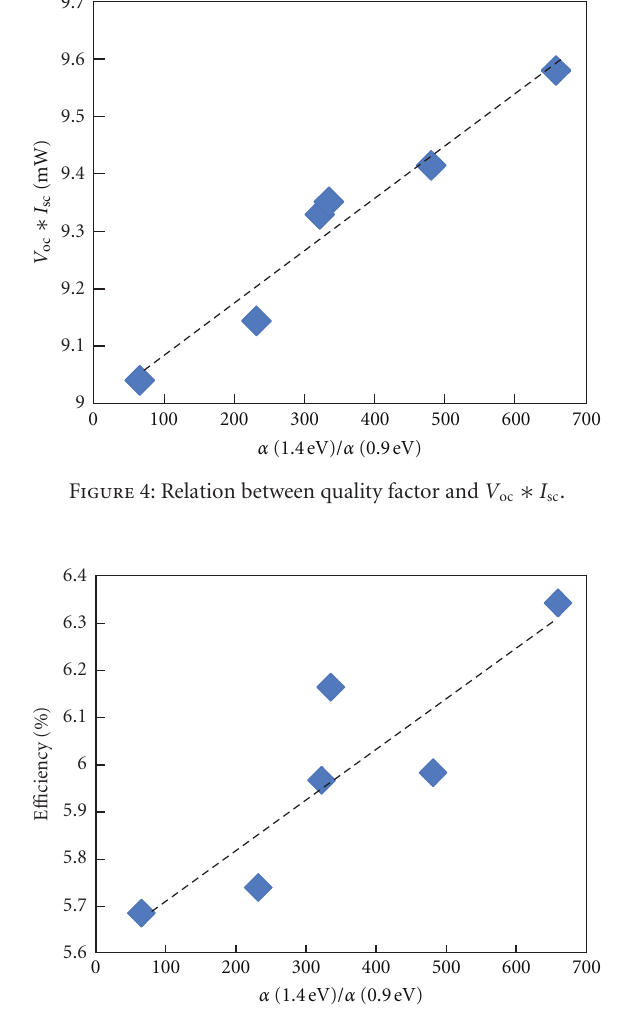
Figure 5: Relation between quality factor and cell e ffi